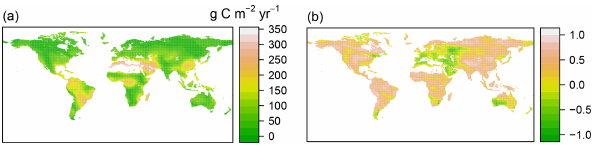
Figure 4. Comparison of RF-RA with Hashimoto2015-RA based on absolute distance (a) and cross correlation (b) .